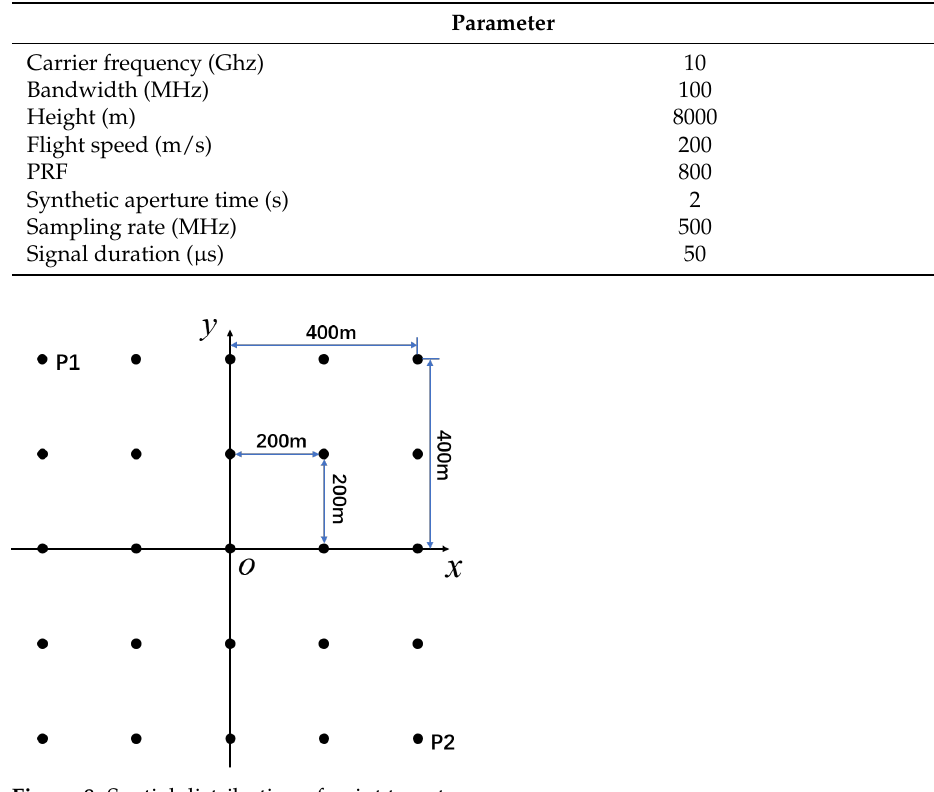
Figure 8. Spatial distribution of point